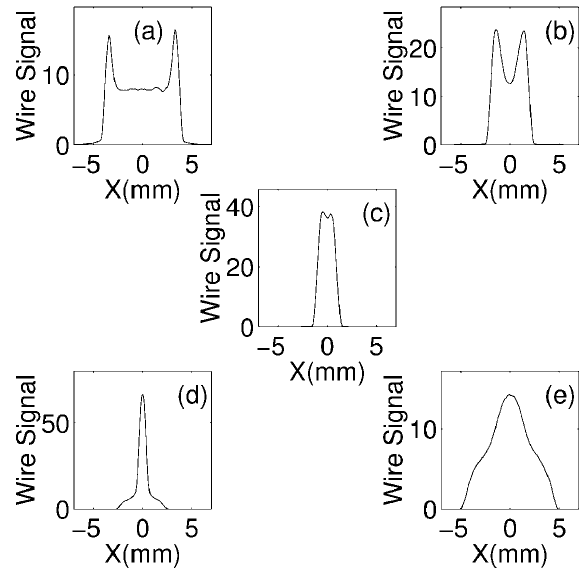
FIG. 5. Simulation of sampling wire distributions for the beam profiles shown in Fig. 4. Relative wire signals are shown on the vertical axes for this figure and for Figs. 6 and 9.